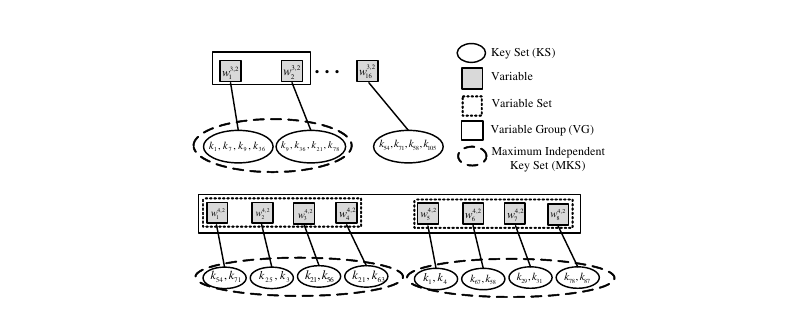
Figure 6: Illustration of the Relationships between Key and Distinguisher